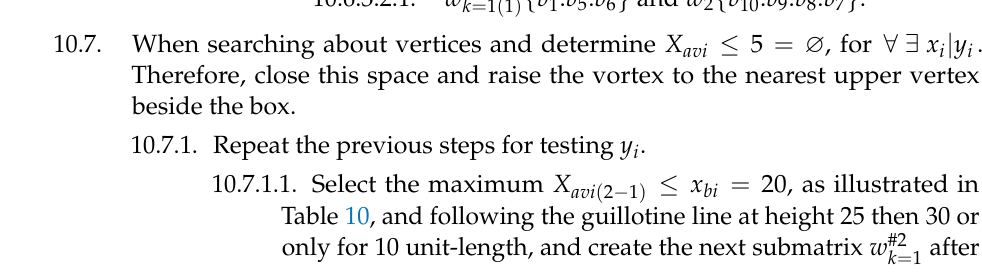
Figure 8. Two branches of stowing based on 𝑿(cid:4652)(cid:4652)⃗ or 𝒀(cid:4652)(cid:4652)⃗ . 10.6.3.2.1. 𝑤 (cid:3038)(cid:2880)(cid:2869)((cid:2869)) {𝑏 (cid:2869) . 𝑏 (cid:2873) . 𝑏 (cid:2874) }𝑎𝑛𝑑 𝑤 (cid:2870) {𝑏 (cid:2869)(cid:2868) . 𝑏 (cid:2877) . 𝑏 (cid:2876) . 𝑏 (cid:2875) } . 10.7. When searching about vertices and determine 𝑋 (cid:3028)(cid:3049)(cid:3036) ≤ 5 = ∅ , for ∀ ∃ 𝑥 (cid:3036) |𝑦 (cid:3036) . Therefore, close this space and raise the vortex to the nearest upper vertex beside the box. 10.7.1. Repeat the previous steps for testing 𝑦 (cid:3036) . 10.7.1.1. Select the maximum 𝑋 (cid:3028)(cid:3049)(cid:3036)((cid:2870)(cid:2879)(cid:2869)) ≤ 𝑥 (cid:3029)(cid:3036) = 20 , as illustrated in Table 10, and following the guillotine line at height 25 then 30 or only for 10 unit-length, and create the next submatrix 𝑤 (cid:3038)(cid:2880)(cid:2869)#(cid:2870) after disposal, all stowage/placement boxes were 𝑏 (cid:2869) . 𝑏 (cid:2869)(cid:2868) . 𝑏 (cid:2877) , as shown in Table 11.